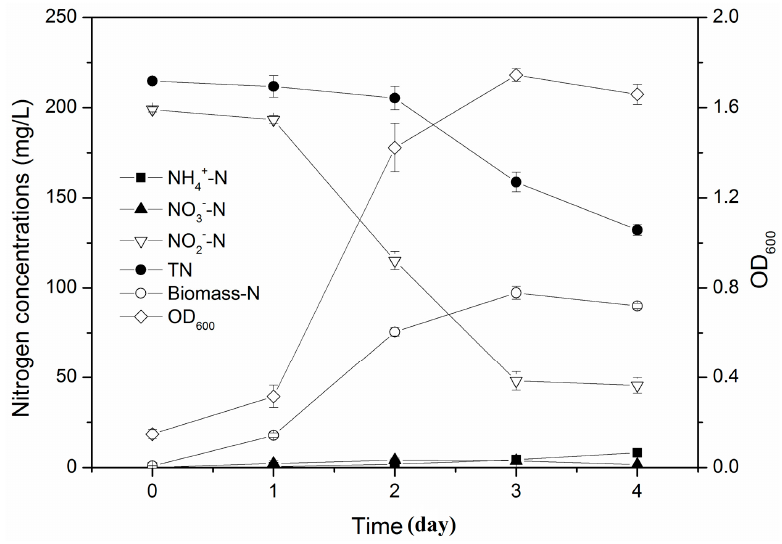
Figure 3. Aerobic denitrification characteristics of strain Y-12 in the presence of NO 2 −